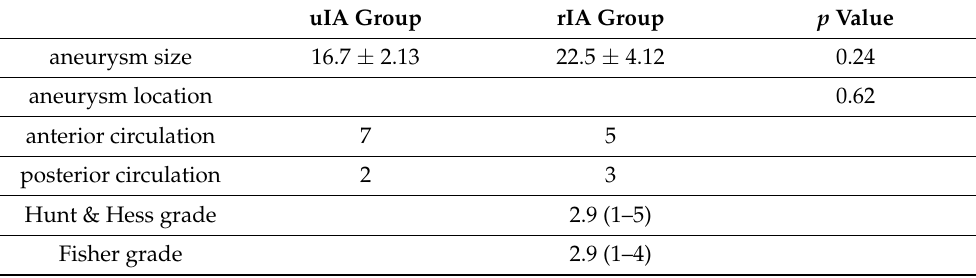
Table 3. Aneurysm differences between